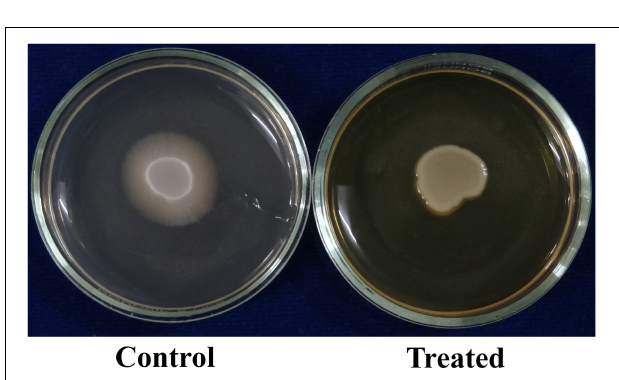
FIGURE 4 | Effect of morin on filamentous morphology. Hyphal morphology was significantly reduced at MBIC concentration (at